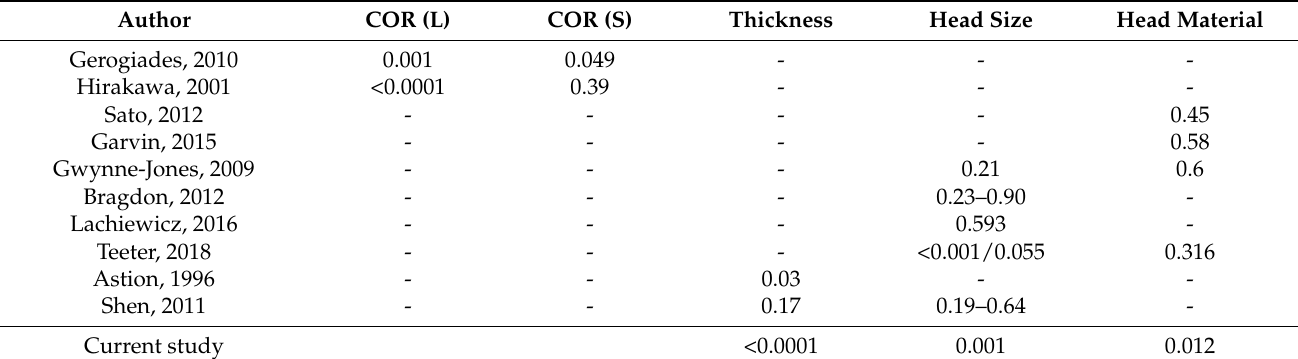
Table 4. Comparative of statistical influence ( p -value) among several authors. COR (L) values for Lateral positioning; COR (S) values for Superior